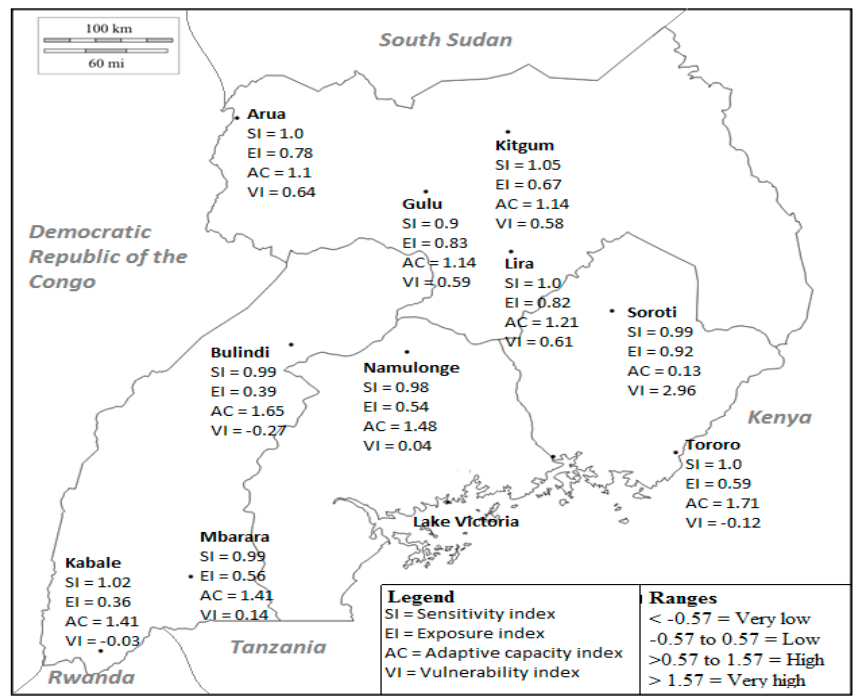
Figure 3. The spatial pattern of crop yield sensitivity, exposure, adaptive capacity and vulnerability indices for various districts/sites in Uganda.